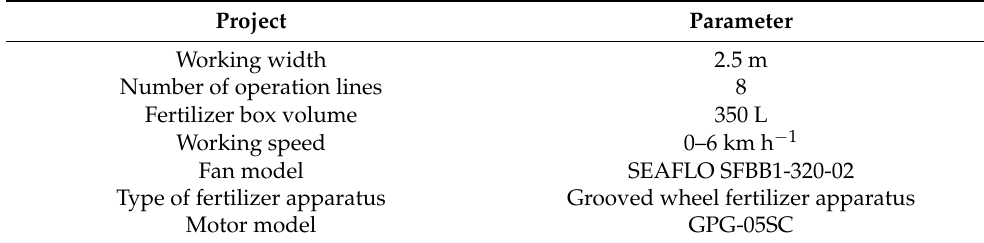
Figure 1. Overall structure of RFW machine. 1. Tractor; 2. Fertilizer box; 3. Fan; 4. Motor; 5. Fertilizer apparatus; 6. Air–fertilizer mixing chamber; 7. Pipe; 8. Height adjustment device; 9. Furrower; 10. Chain transmission box; 11. Weeding wheel; 12. Limiter spring; 13. Fertilizer tank; 14. Depth-limiting plate. Table 1. Technical specifications of RFW machine.